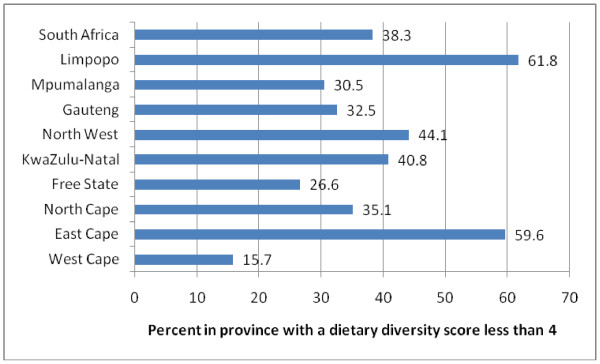
Percentage population (with 95th CI) in each province having a dietary diversity score less than 4.